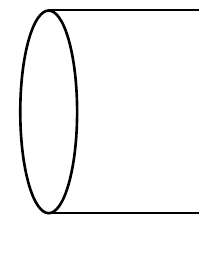
Figure 4 . Kernel operator.